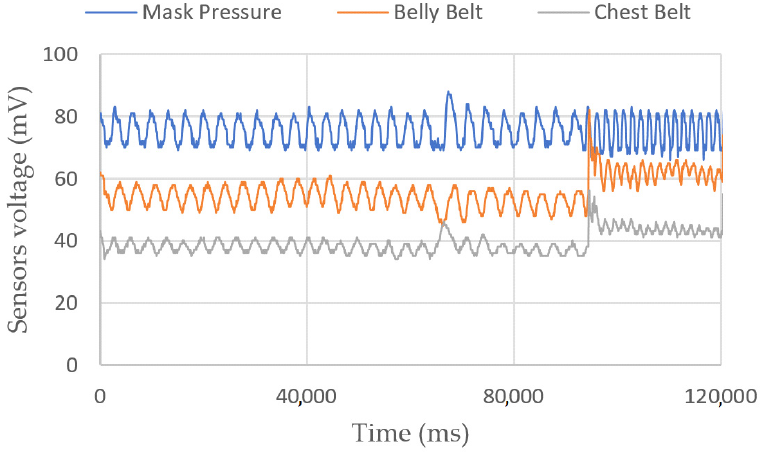
Figure 4. Belts and pressure sensors’ voltages vs. time. The target wanted to test various breathing styles, as shown by the strong inhalation near 70 s and the fast breathing after 90 s.